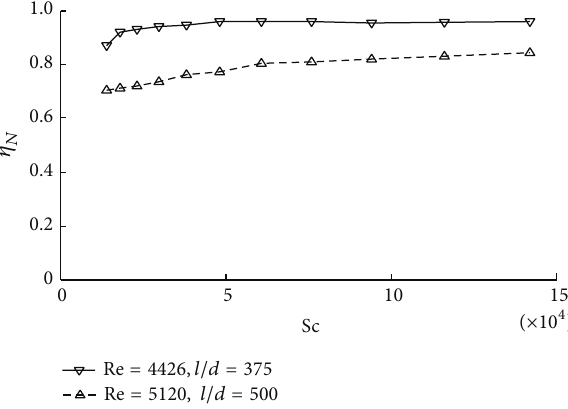
Figure 4: Penetration efficiencies for different Re at 𝜏 = 375 .